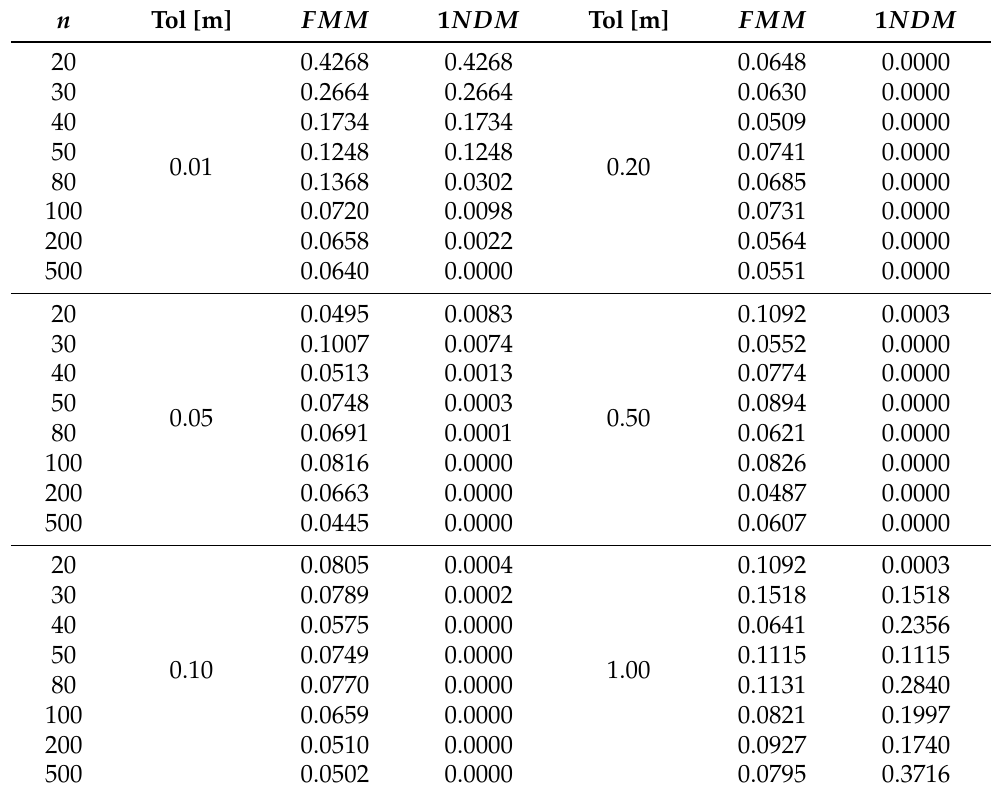
Table 8. NMAS test: proportion of times where the null hypothesis is rejected for several metric tolerances ( α = 0.05) when using the Finite Mixture Model (FMM) and the One Normal Distribution Model 1NDM (based on 5000